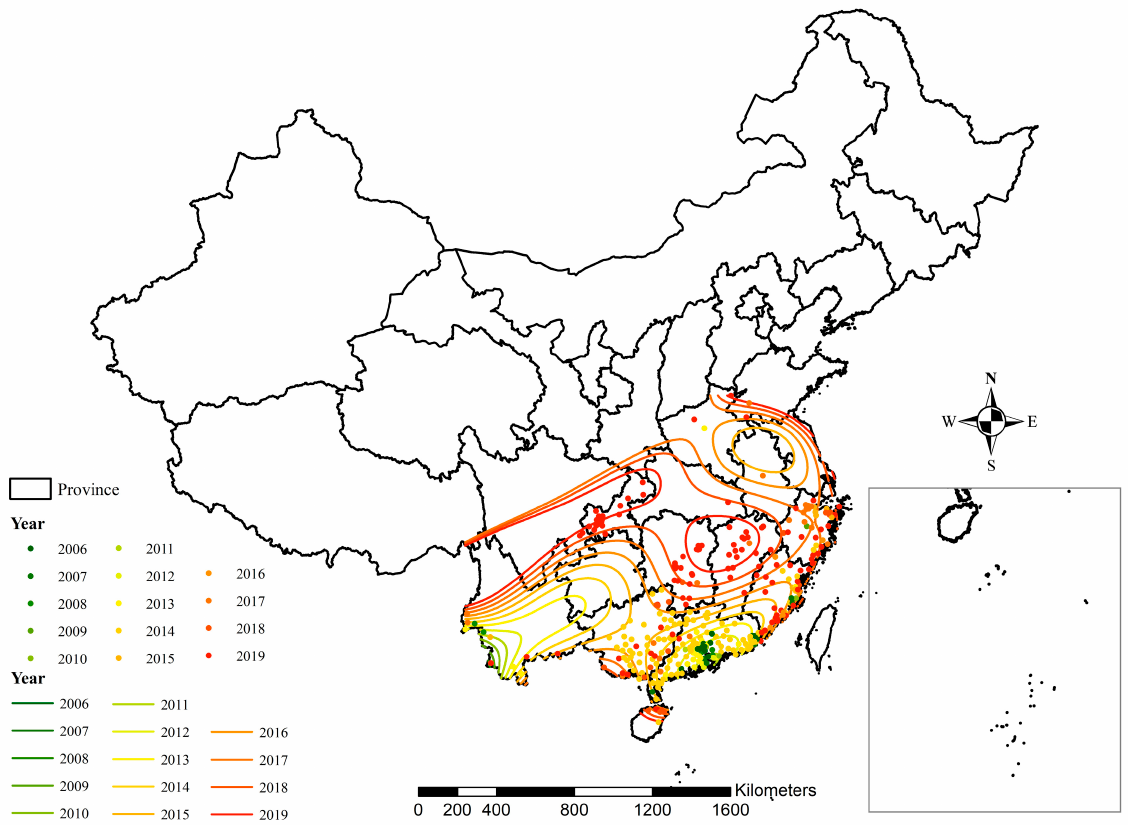
Figure 5. Spatial diffusion of indigenous dengue fever in mainland China, 2005–2019.